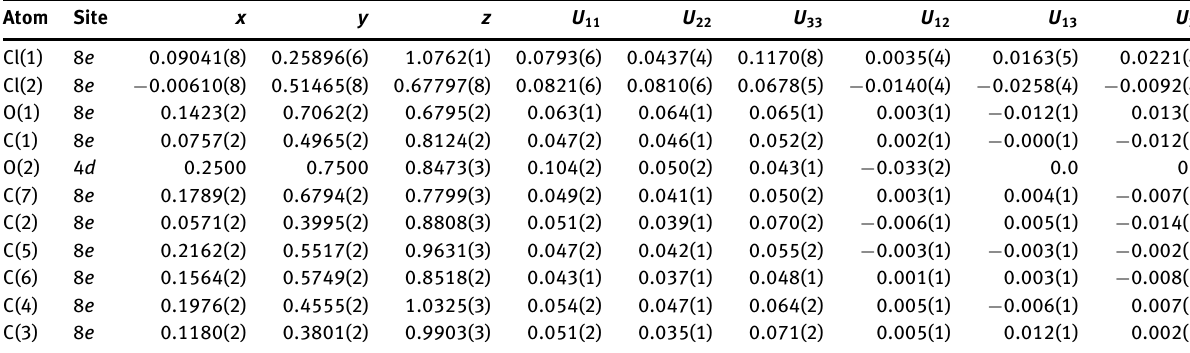
Table 3: Atomic coordinates and displacement parameters (Å 2